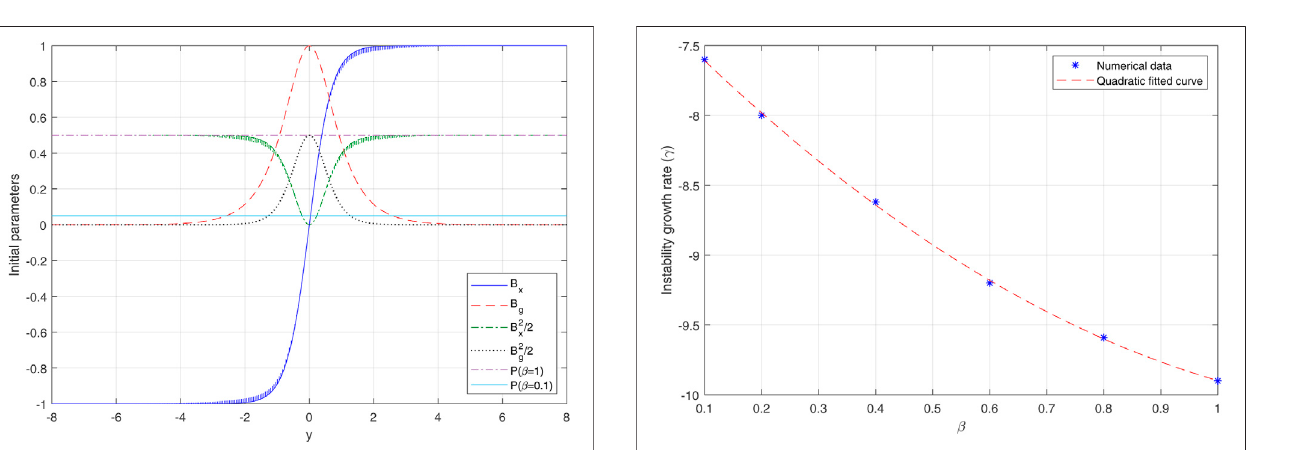
FIGURE10| Theinitialgasandmagneticpressures,andthestructureof the magnetic fi elds.